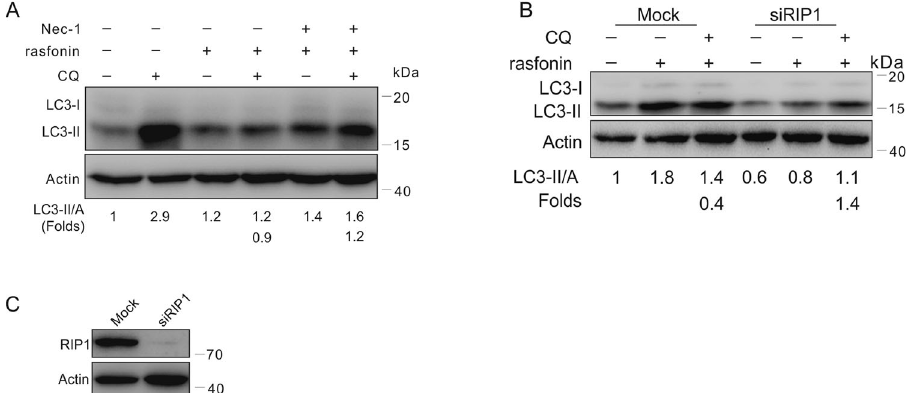
Fig. 2 Rasfonin failed to inhibit autophagy in RIP1-deprived cells. A ACHN cells were treated with rasfonin (12 μ M) with or without Nec-1 (30 μ M) for 4 h, and then cell lysates were prepared and analyzed by immunoblotting using the indicated antibodies. B , C After transfection with the control (Mock) or RIP1 siRNA (siRIP1) for 48 h, ACHN cells were treated with rasfonin (12 μ M) for 4 h. Cell lysates were analyzed by immunoblotting with the indicated antibodies. Actin was used as a loading control. Similar experiments were repeated at least three